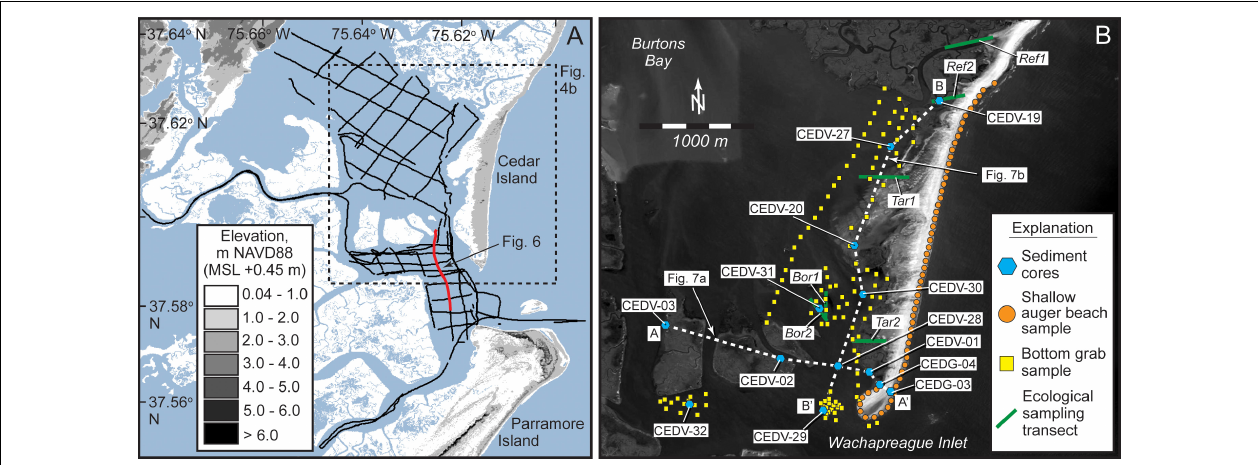
FIGURE 4 | Map of southern Cedar Island and vicinity showing locations of field mapping and data collection. (A) Locations of ∼ 30 km of shallow-seismic profiles (black lines) overlain on digital elevation model (topographic and shallow bathymetric lidar; OCM (National Oceanic and Atmospheric Administration Office for Coastal Management) Partners, 2020c). (B) Sedimentologic and ecologic data collection. The former consists of 121 bottom grab samples, 57 shallow-auger beach sediment samples, 11 vibracores (labeled “CEDV-xx”), and two direct-push Geoprobe cores (labeled “CEDG-xx”). Ecological data were collected along six transects, with two each in reference marshes (labeled “ Ref1 ” and “ Ref2 ”), prospective project area marshes (labeled “ Tar1 ” and “ Tar2 ”), and a representative borrow site (labeled “ Bor1 ” and “ Bor2 ”). Background image is December 2018 orthophoto from the National Agriculture Imagery Program, administered by the US